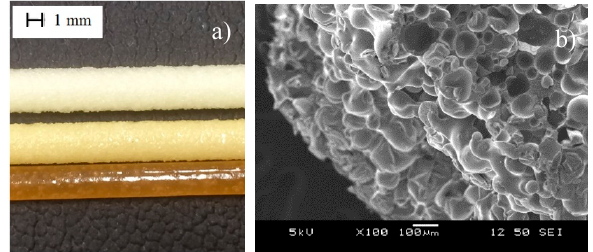
Figure 5. ( a ) The color of the produced foam structures at 190, 210, and 230 ◦ C; ( b ) foam structure surface at 190 ◦ C with 4.3% d -lactide content and with 8 wt%